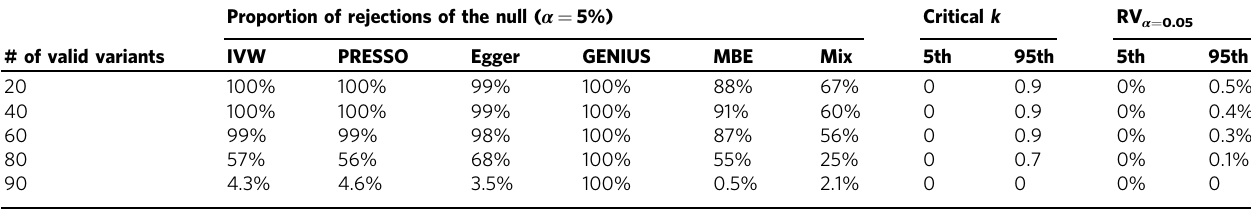
Table 4 Simulation in which pleiotropic pathways are concentrated on only a subset of